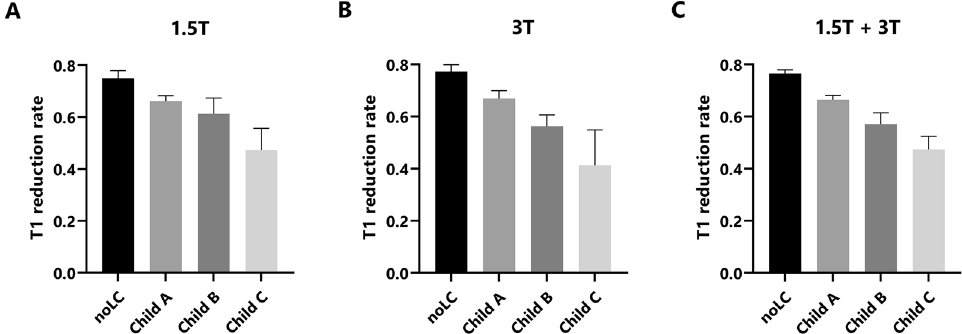
Figure 2. T1 reduction rates for different patient groups. The median and 95% confidence interval of T1 reduction rates on the y-axis are shown for the 4 liver groups: no liver cirrhosis (noLC) and liver cirrhosis